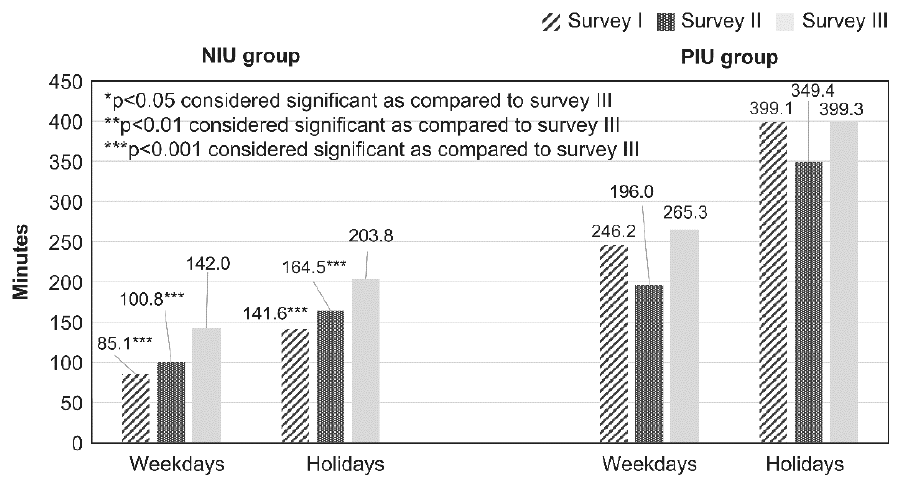
Figure 4. Comparison of average daily Internet minutes on weekdays and holidays for each